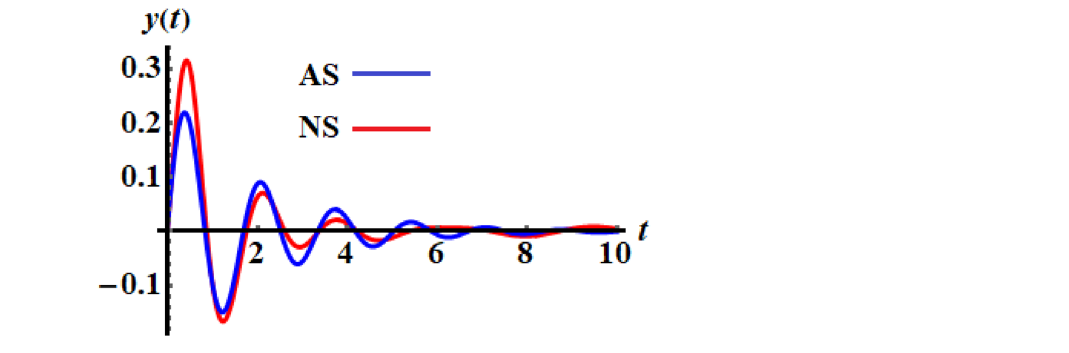
Figure 3. Signifies the connection of the AS and the NS at τ = 0.5